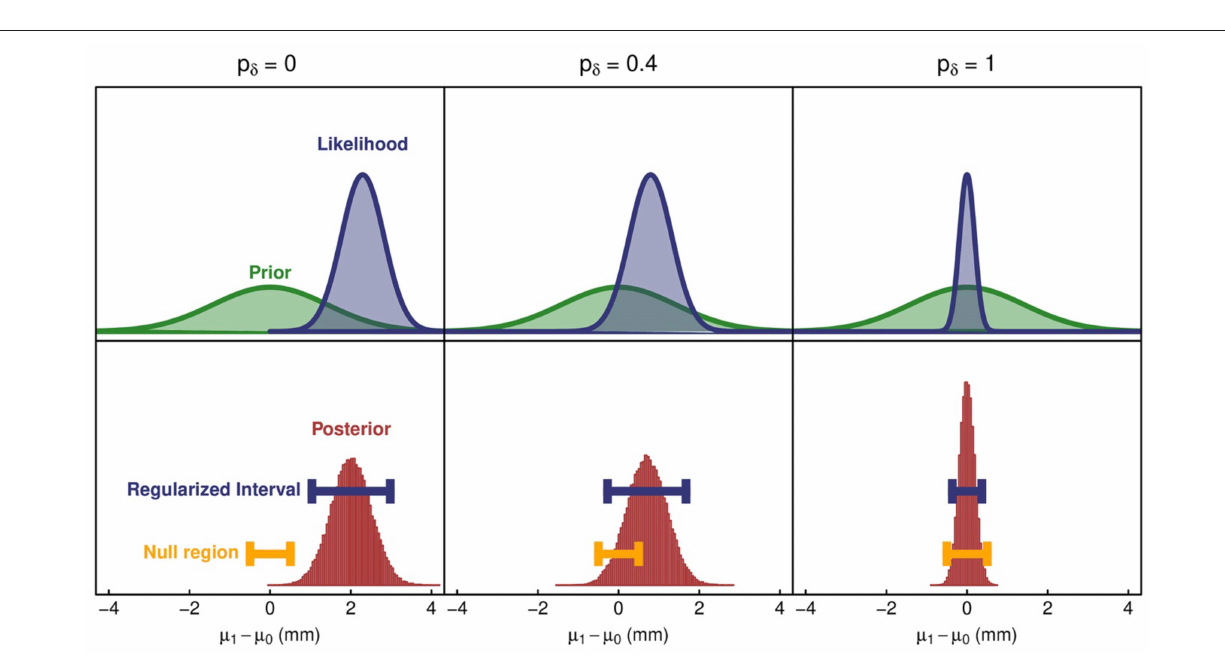
0. A larger null region from − 1 to 1 mm is needed to have any chance of